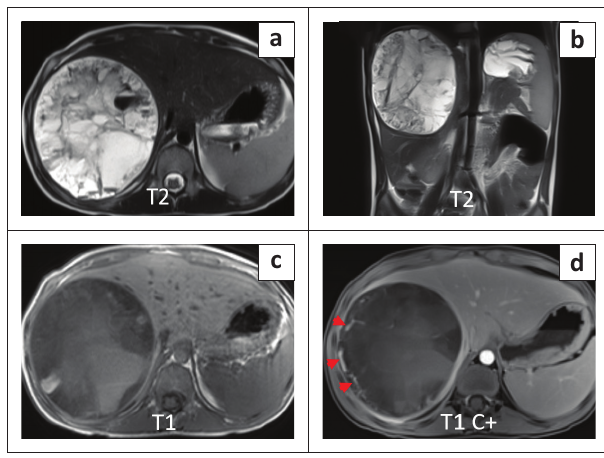
a b FIGURE 3: (a) Axial and (b) coronal T2W images showing a hyperintense cystic appearing lesion with heterogeneous internal components and fluid-fluid levels; (c) Axial T1W image revealing hyperintense, internal haemorrhagic contents; (d) Post-contrast T1W image indicating only peripheral vascularity (red arrow heads) with no obvious internal solid enhancing soft tissue.